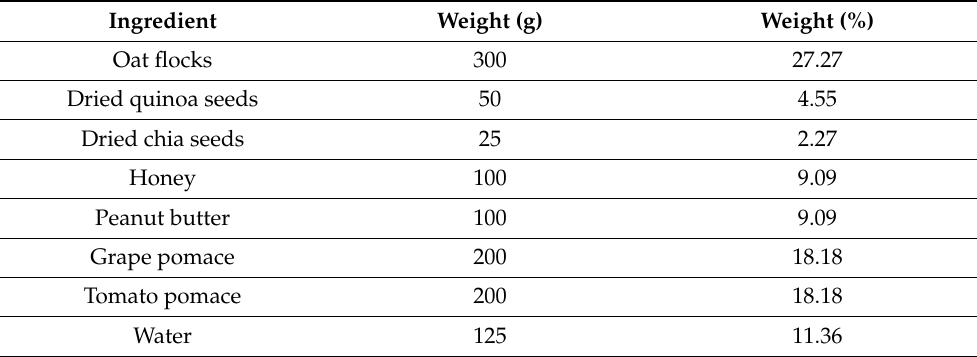
Table 1. List of the ingredients used in the final recipe (for three